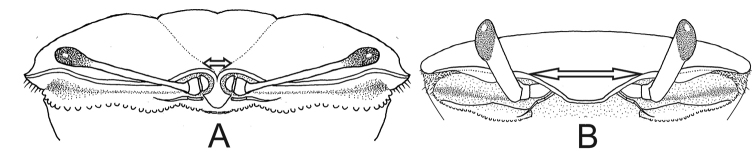
Carapace, frontal view. AUca
maracoani: spatulate and narrow front (seta) BMinuca
burgersi: triangulate and wide front (seta).